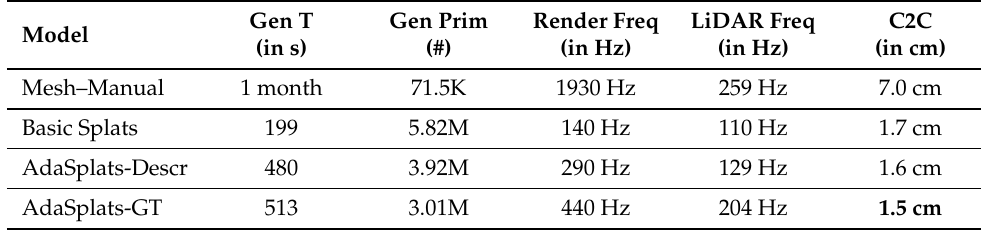
Table 6. Results on M-City. We report the time taken (Gen T) in seconds to generate the primitives (triangular mesh or splats), the number of generated primitives (Gen Prim) in millions (M), rendering frequency in Hz (Render Freq) with a resolution of 2560 × 1440 pixels, LiDAR simulation frequency (LiDAR Freq) of the Velodyne HDL-64, and cloud-to-cloud (C2C) distance between the simulated and original point